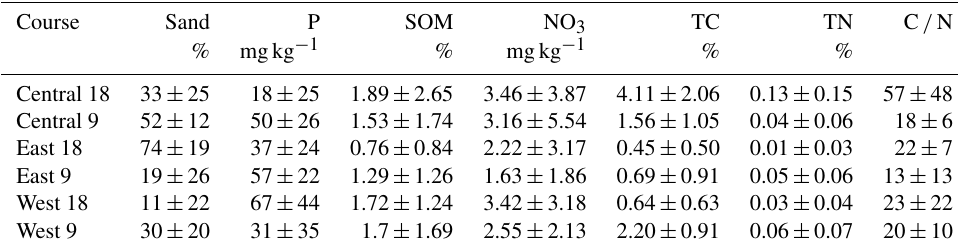
Table 4. Soil conditions (mean and standard deviation) by course at Iowa golf courses.